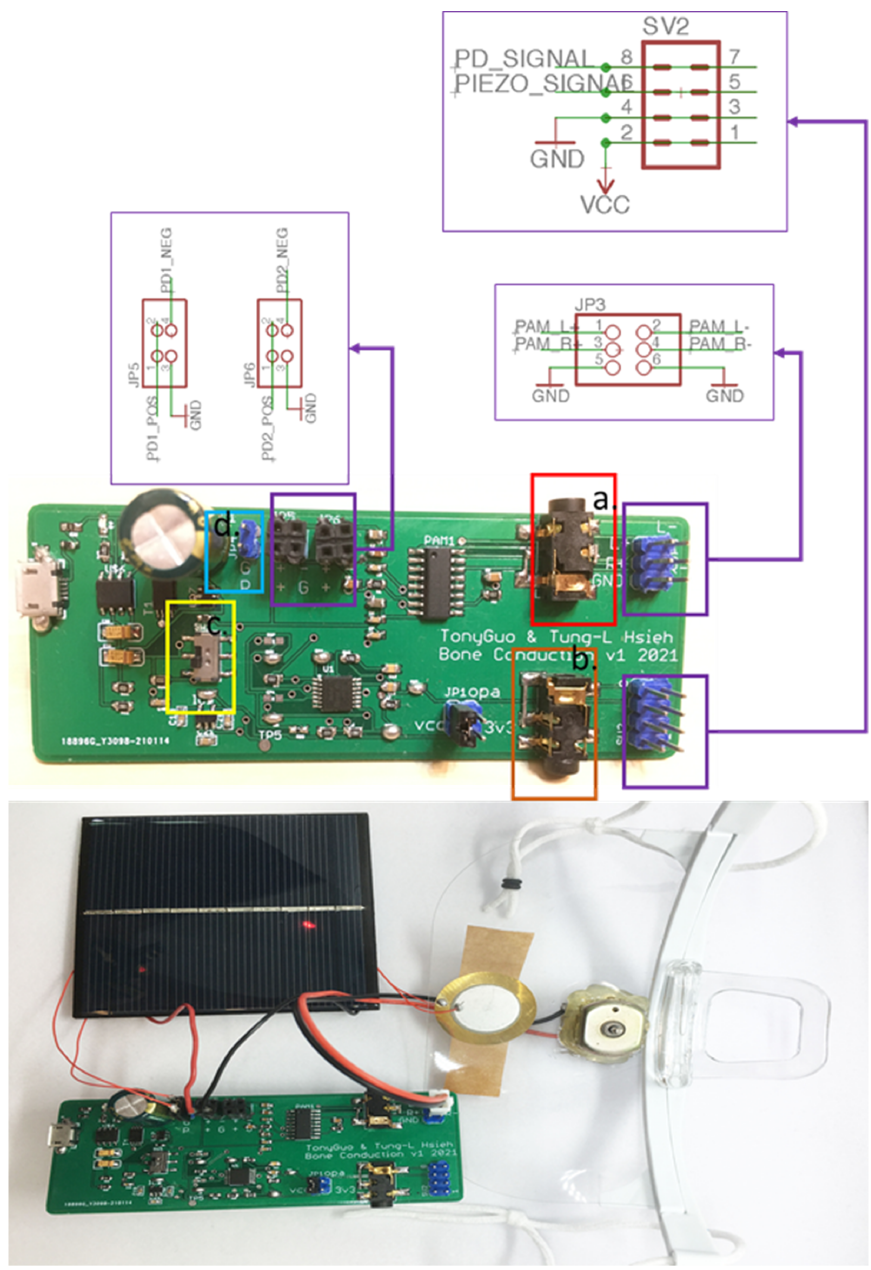
Figure 6. Laser audio signal receiver. a shows the PAM8403 output earphone, which can drive bone conduction. b shows the trans-impedance amplifier (TIA) output earphone, which can be used to listen to the sound transmitted by the solar panel or photodiode. c displays the power switch, which turns on and off. d displays the input of the piezoelectric sensor.